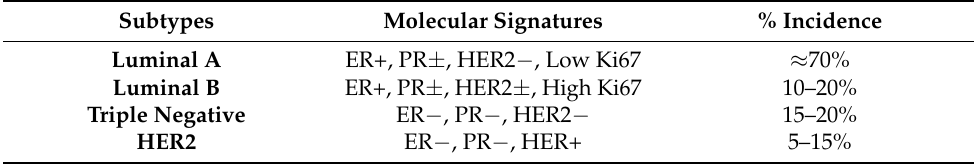
Table 1. Molecular subtypes of breast cancer.